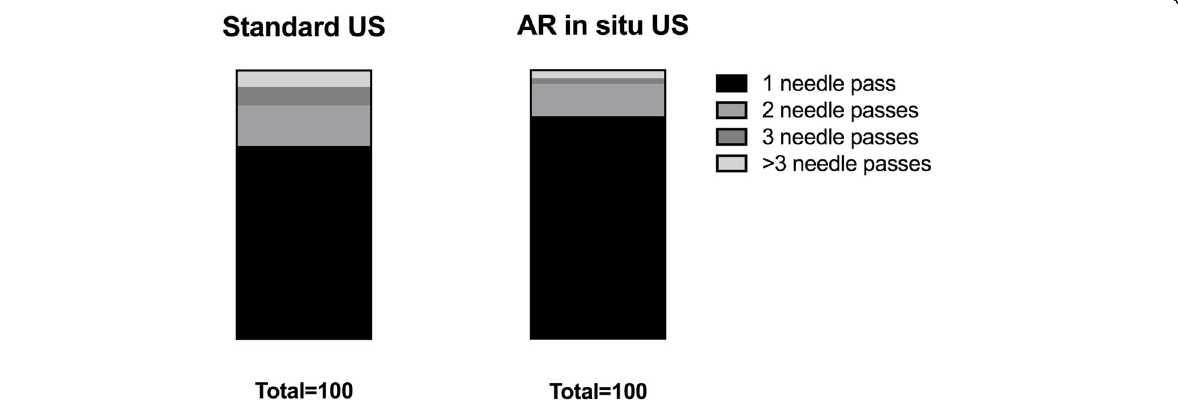
Fig. 5 Differences of number of needle passes to target puncture of all operators using the standard ultrasound versus augmented reality in situ ultrasound technique